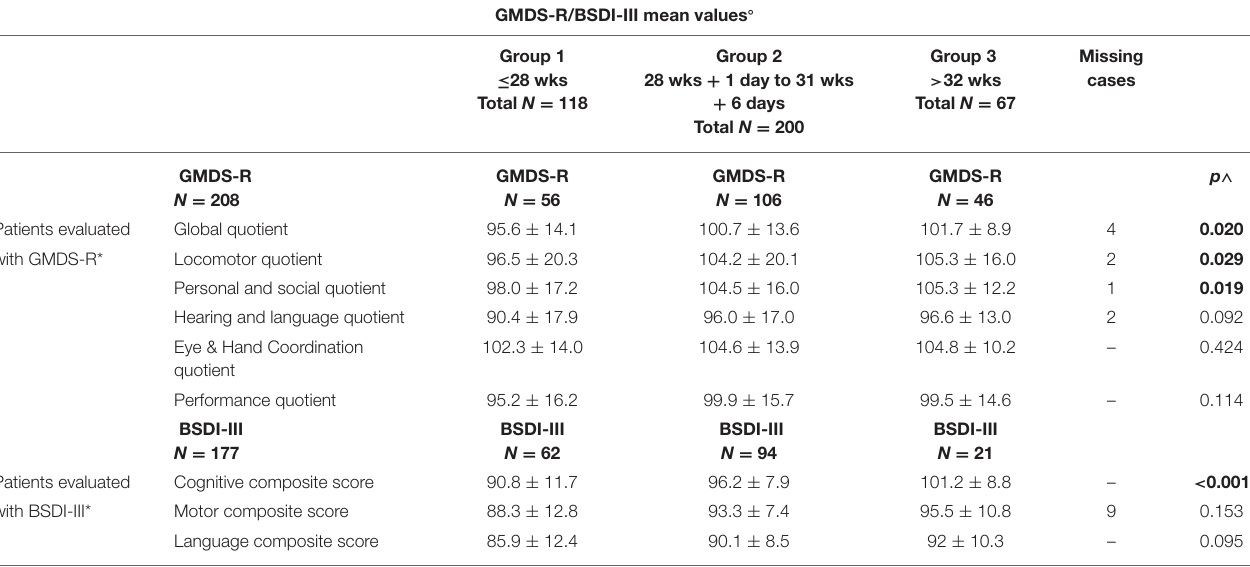
TABLE 5 | Comparison of GMDS-R quotients or BSD-III scores among 3 groups with different gestational